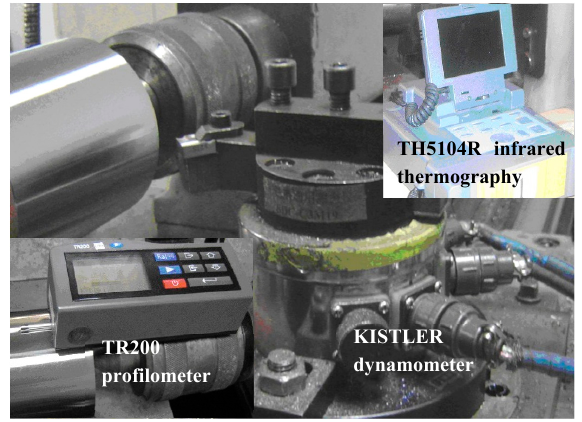
Figure 3. Experimental setup in dry cutting of hardened steel.